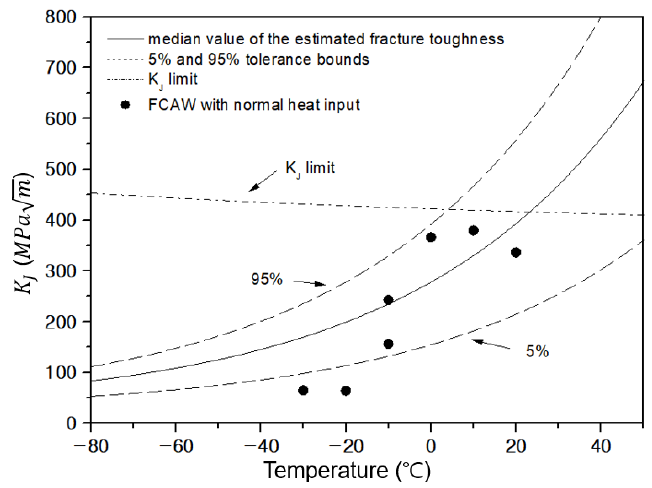
Figure 14. Master curve for FCAW, normal heat input condition with CTOD test results.